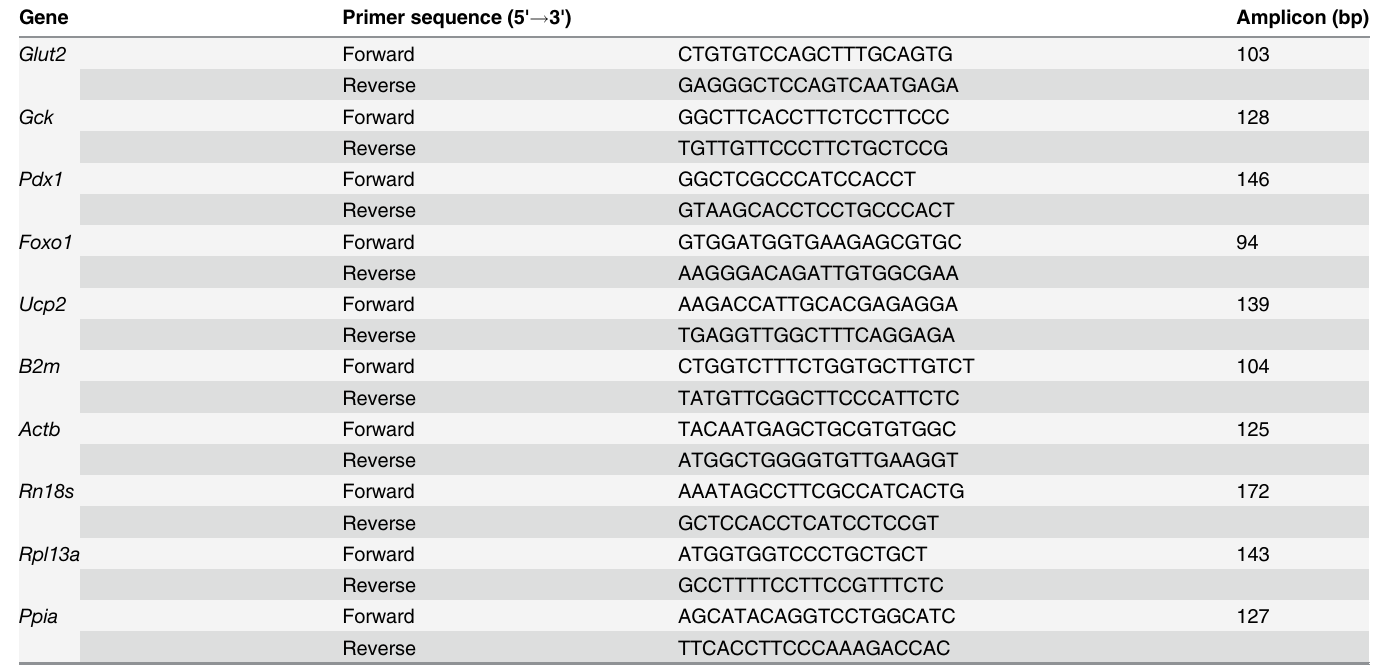
Table 1. Sequences of primers for RT-PCR used in this study.